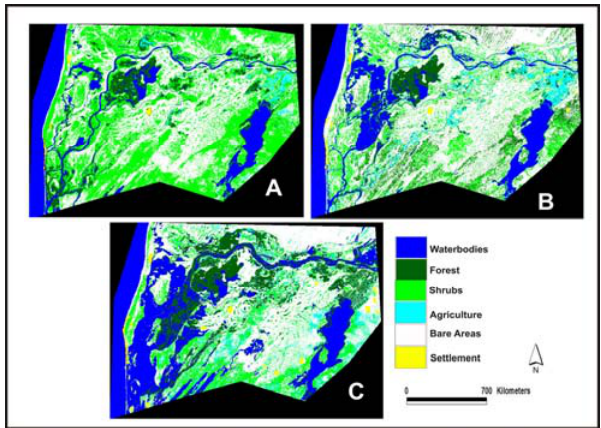
Figure 4: False-color image of Landsat MSS, TM, ETM+ images of Senegal Basin. 1979 image is displayed as RGB 231 in (A). The 1987 and 1999 images are displayed as RGB 742 respectively in B and C.